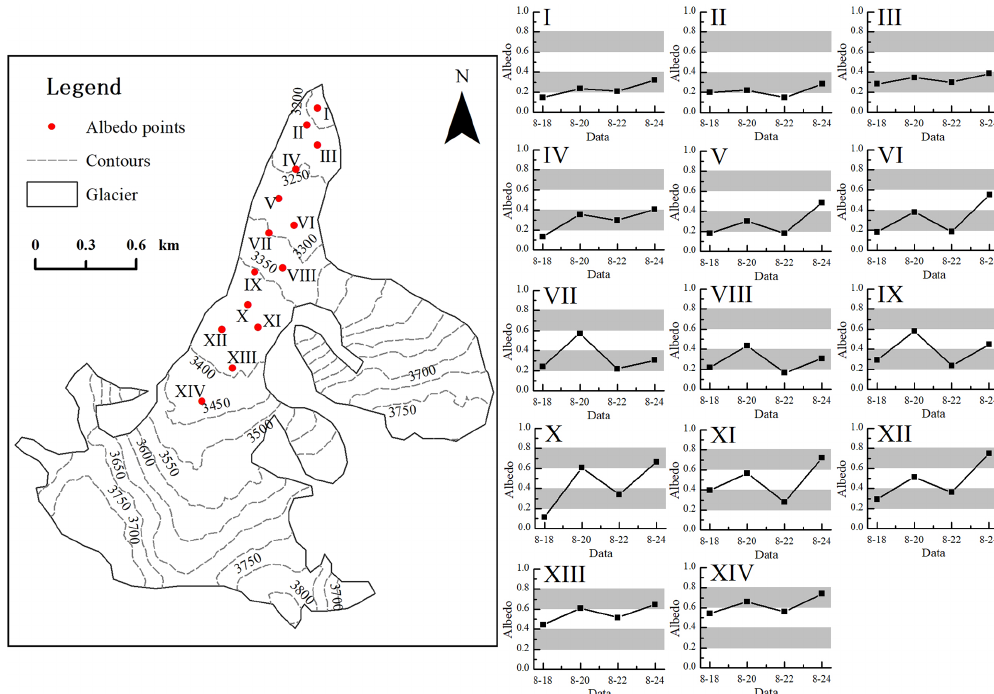
Figure 7. The surface albedo at the 14 sites (I–XIV) of the Muz Taw Glacier, where the red points denote the sites. The map on the left-hand side is the reference for the 14 charts (sites I–XIV) and marks the albedo scale and date with the grey shading. Table 2. The positively accumulated temperatures, snowfalls, and albedo measured by the instruments on the AWS at ELA, and the calculated mass balances of the Muz Taw Glacier before and after the two artificial snowfall experiments ( t 1 = 12–18 August and t 2 = 18–24 August). Period Positively accumulated Snowfall Albedo Mass balance temperature ( ◦ C) (mmw.e.) (mmw.e.) t 1